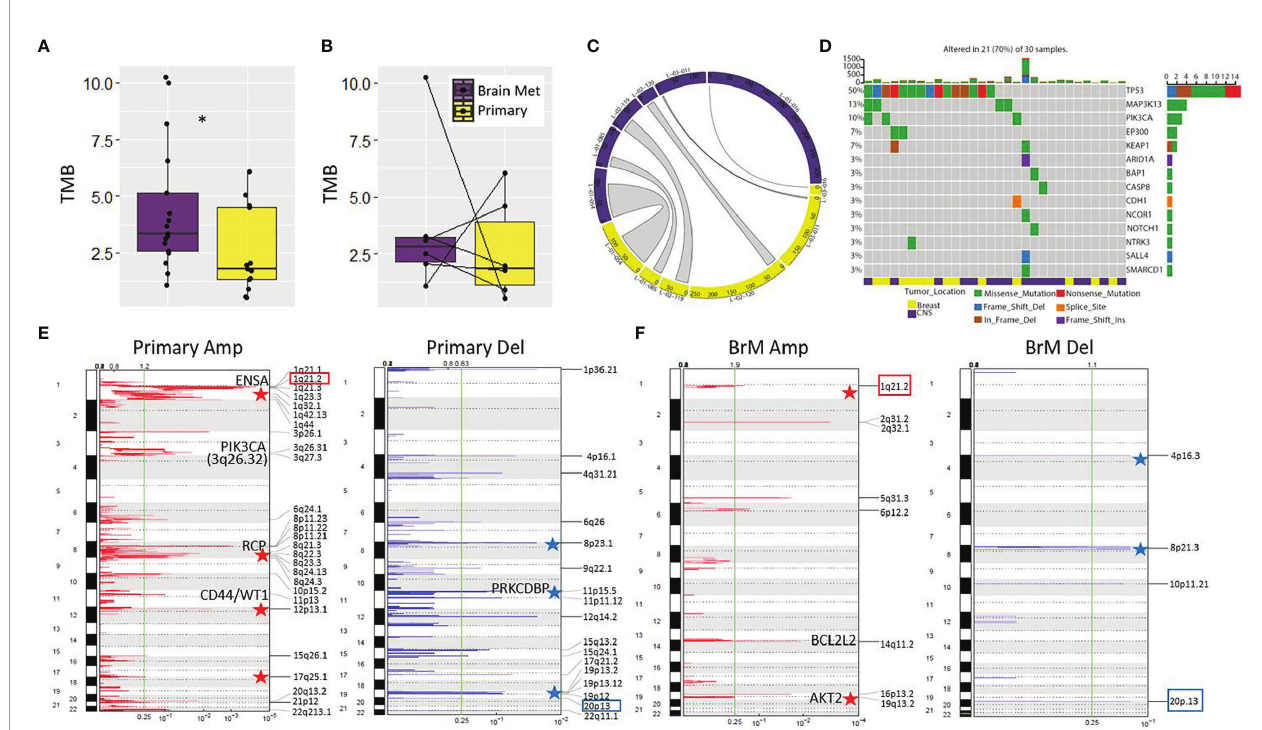
FIGURE 1 | Mutational analysis of the LCCC1419 cohort. (A) Increased tumor mutational burden (TMB) was observed for BrM ( n = 17) relative to primary ( n = 13); * p < 0.05, Wilcoxon rank-sum test. (B) No difference was observed between TMB for matched pairs ( n = 6). (C) Circos plot showing the total number of variants and the proportion of variants shared between matched primary/BrM ( n = 6). (D) Oncoprint displaying the mutational spectrum of cancer-associated genes with known etiology to breast cancer (COSMIC Tier 1, Sanger Institute). Representation of the somatic copy number alterations in (E) primary TNBC and (F) BrM as determined by CNVkit/GISTIC 2.0 analysis. Signi fi cant amplicons (Amp) or deleted (Del) regions are annotated ( q < 0.25, green line). The 1q21.2 ampli fi cation and the 20p13 deletion, which are shared genomic features of primary and BrM TNBC, are highlighted by colored boxes. Relevant oncogenes and tumor suppressors are annotated on the plots, and stars indicate genomic regions where copy number alterations are known to contribute to breast cancer/aggressive basal breast